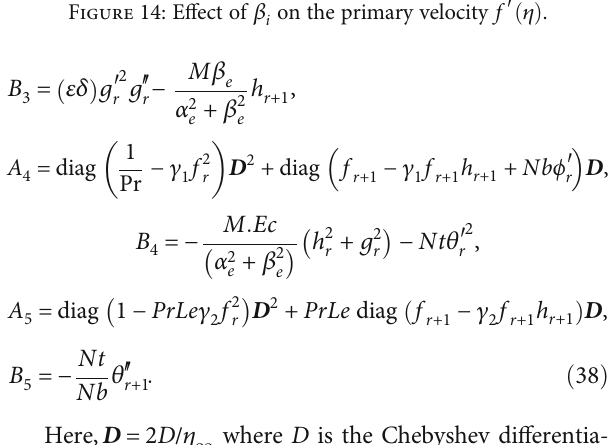
Figure 12: E ff ect of β